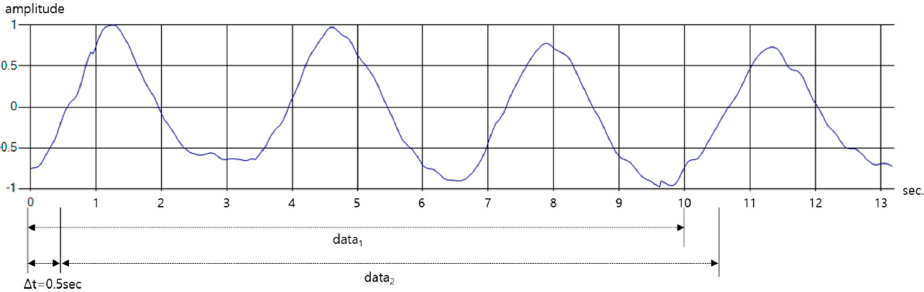
Figure 13. Breathing signal data extracted through UWB Radar.